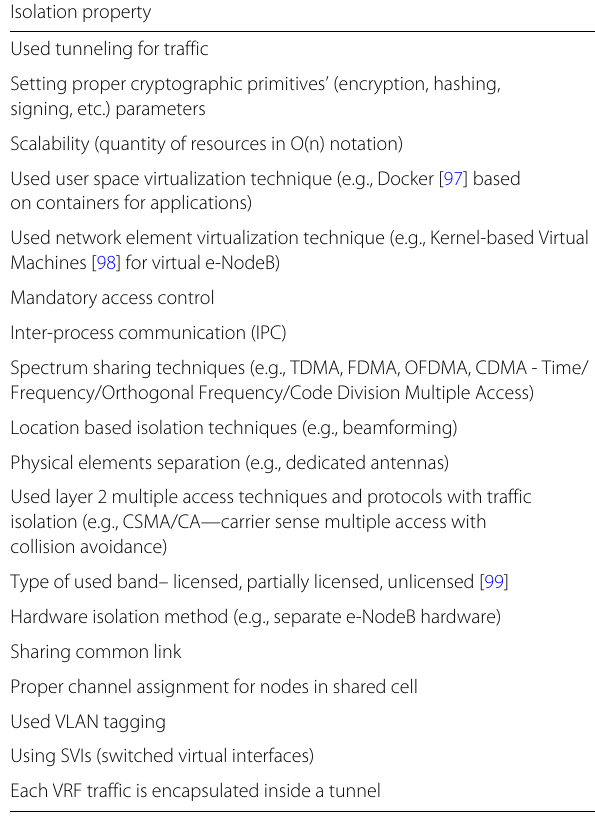
Table 1 Examples of isolation properties Isolation property Used tunneling for traffic